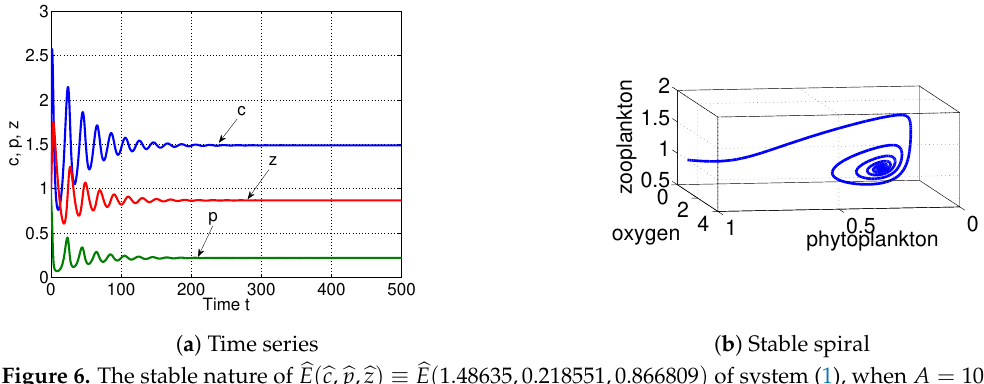
Figure 6. The stable nature of (cid:98) E ( (cid:98) c , (cid:98) p , (cid:98) z ) ≡ (cid:98) E ( 1.48635,0.218551,0.866809 ) of system (1), when A = 10 and the remaining parameters are same as in Figure 4. Initial conditions: c ( 0 ) = p ( 0 ) = z ( 0 ) = 1.